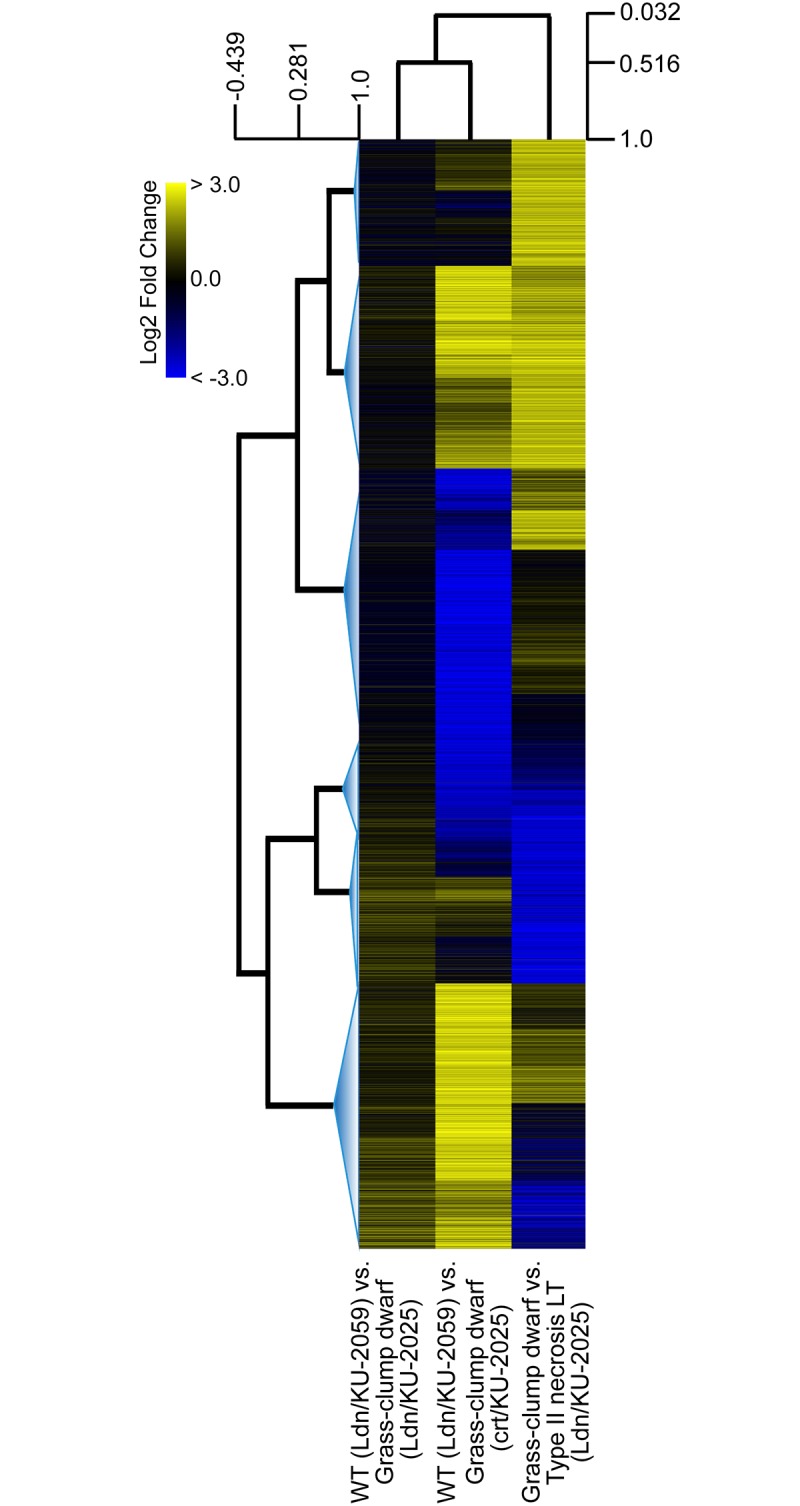
Heat map for the altered gene expression levels of the selected 9,974 probes in the three examined crown tissues; WT (Ldn/KU-2059) and grass-clump dwarf (Ldn/KU-2025), WT (Ldn/KU-2059) and grass-clump dwarf (Ldn/KU-2025), and grass-clump dwarf (Ldn/KU-2025) under the normal temperature and LT.The branches of the trees are arranged according to the Pearson correlation coefficients. The distance threshold adjustment resulted in six major clusters. The colour-scale shows log2 fold change values.